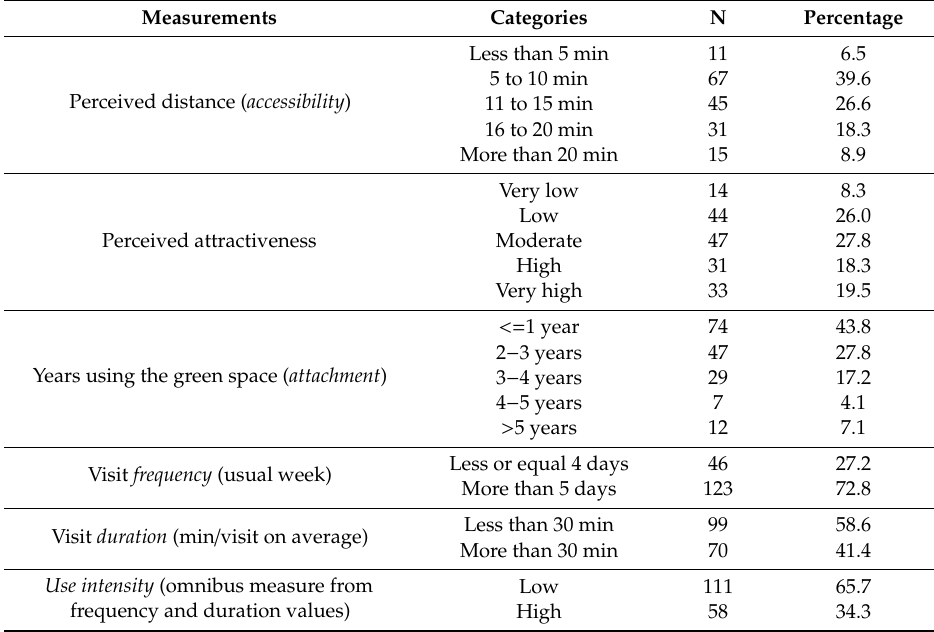
Table 3. Green space characteristics and use patterns among middle-aged residents in